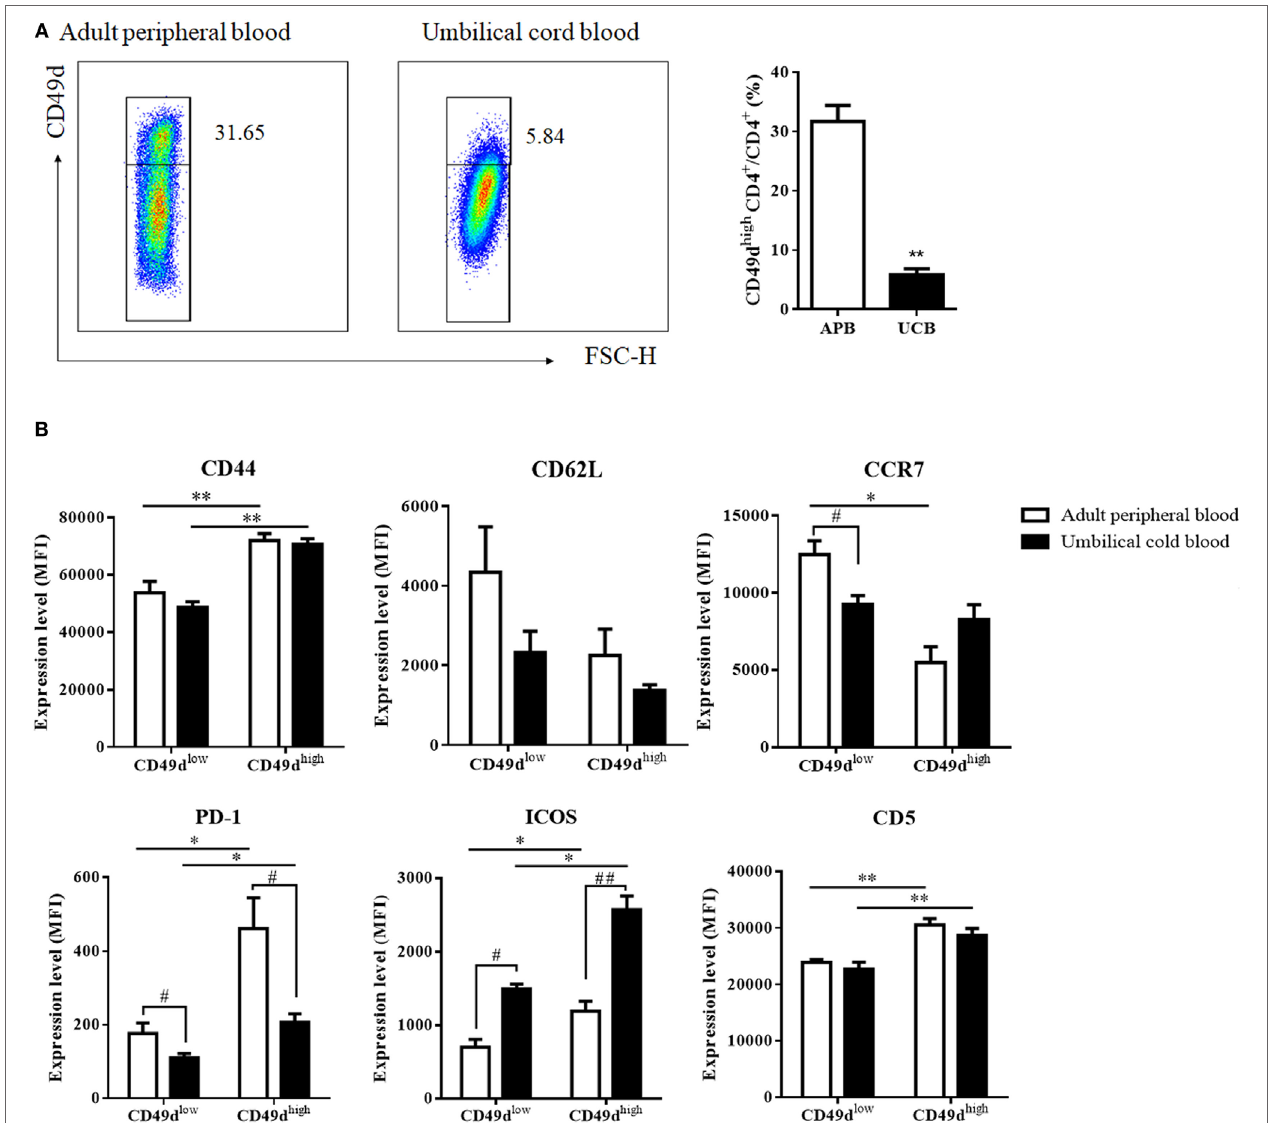
FigUre 4 | CD49d high CD4 + T cells from the umbilical cord exhibit a similar Th1-like memory phenotype. (a) CD4 + T cells from the PB of healthy adult donors or UCB were analyzed for CD49d expression. Proportions of CD49d high CD4 + among CD4 + T cells in the APB (white) and the UCB (black) are shown. CD49d high CD4 + cells were also identified in the UCB; however, proportions were lower in the UCB than in the APB. Data are representative of three independent experiments. (B) When expression levels of various cell surface proteins (CD44, CD62L, CCR7, PD-1, ICOS, and CD5) in CD49d high CD4 + T cells were compared between APB and UCB, cell surface phenotypes of CD49d high CD4 + T cells in the UCB showed similar patterns as those in APB. Data are expressed as the mean ± SEM ( n = 3 donors per each group). * P < 0.05, ** P < 0.01 in the comparison between CD49d high CD4 + T cells and CD49d low CD4 + T cells; # P < 0.05, ## P < 0.01 in the comparison between APB and UCB; Student’s t -test. Abbreviations: APB, adult peripheral blood; UCB, umbilical cord blood; MFI, mean fluorescence intensity; PB, peripheral